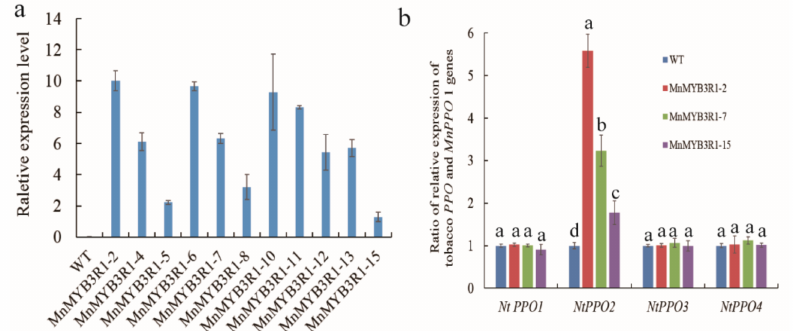
Figure 5. Identification of MnPPO1 homologs in tobacco. ( a ) Quantitative results of MnMYB3R1 expression in transgenic tobacco lines; ( b ) ratio of the relative expression of NtPPO in the wild-type and transgenic tobacco